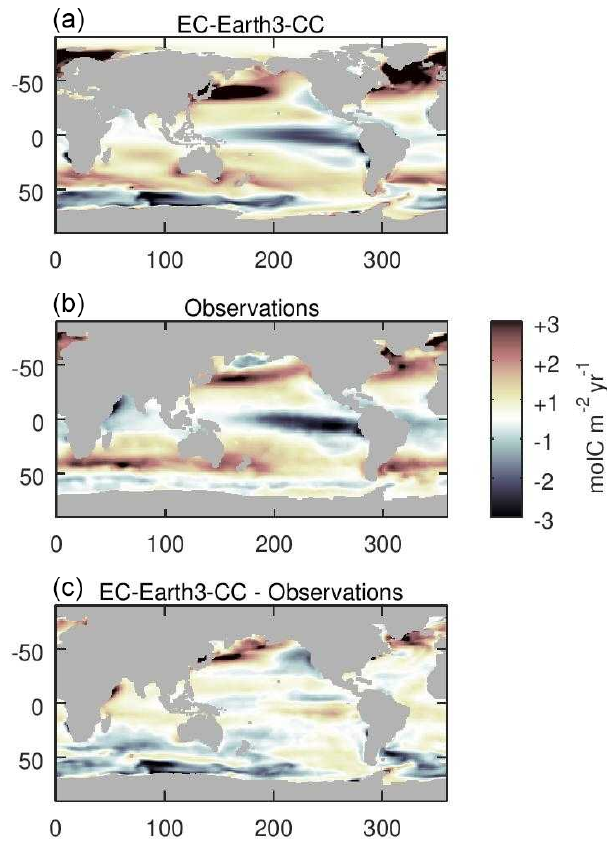
Figure 22. Air–sea CO 2 flux averaged over the period 1982– 2014 for EC-Earth3-CC (a) , the observation-based reconstruction by Landschutzer et al. (2016; b ), and their difference (c) .